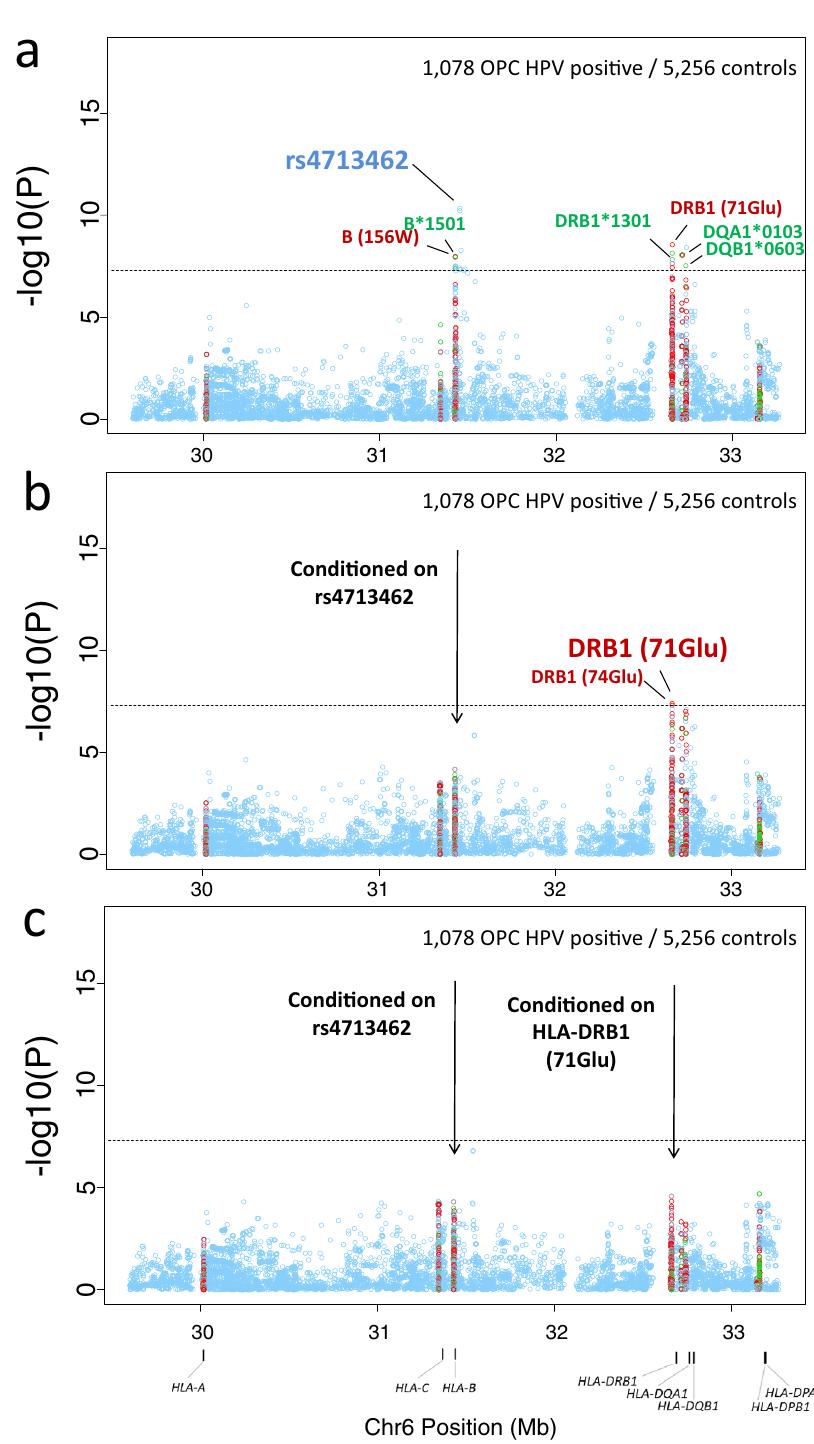
Fig. 2 Plots of stepwise conditional association in the MHC region for HPV( + )OPC cases. a – c The association for each locus used for conditioning is shown in each panel: a unconditioned, b conditioned on rs4713462, c conditioned on rs4713462 and HLA-DRB1 amino acid change in position 71 (71-Glu). Detailed association results in Table 2 and Supplementary Fig. 2. Circles represent – log10 ( P values) for each binary marker using the imputed allelic dosage (between 0 and 2) and genotyped variants. Multivariable logistic regression assuming a log-additive genetic or dosage model with age, sex, and eigenvectors as covariates was used as baseline model. The dashed black horizontal lines represent the study-wide signi fi cant threshold of P = 5 × 10 − 8 . The physical positions of HLA genes on chromosome 6 are shown at the bottom. The color of the circles indicates the type of marker; light blue — SNPs outside and within HLA genes, green - classical HLA alleles and red — amino acid polymorphisms of the HLA genes. HLA human leukocyte antigen, MHC Major Histocompatibility Complex, HPV human papillomavirus, OPC, oropharyngeal